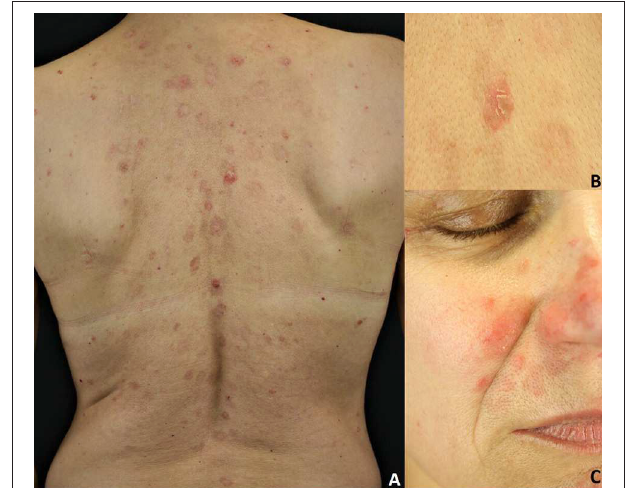
FIGURE 3 | Pemphigus foliaceus: (A) Scaly and crusted erythematous plaques on the seborrheic areas; (B) Leafy and crusted circumscribed erosion on the back; (C) Scaly erythematous plaques on the seborrheic areas. All the patients gave written informed consent for the publication of the